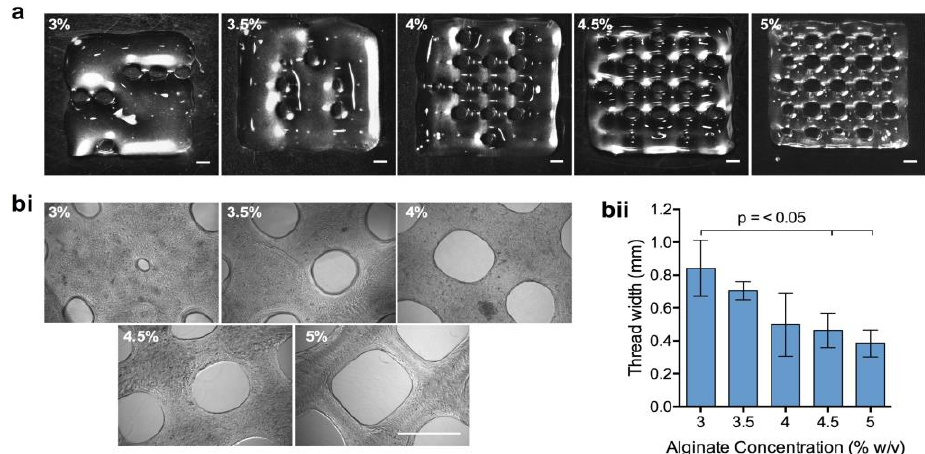
Figure 5. Printability of different bioink formulations. Calcium alginate beads were dissolved in 50 mM sodium citrate before mixing with high viscosity alginate (HV-alginate) to reach final concentrations of between 3 and 5%. Lattice constructs were printed using an extrusion-based bioprinter ( a ) before gelation and examination of print fidelity by phase-contrast microscopy ( bi ). Print fidelity was quantified by measuring thread width ( bii ). Values are presented as means ± SD from 3 independent experiments. p < 0.05 was considered significant. Scale bars = 2 mm.